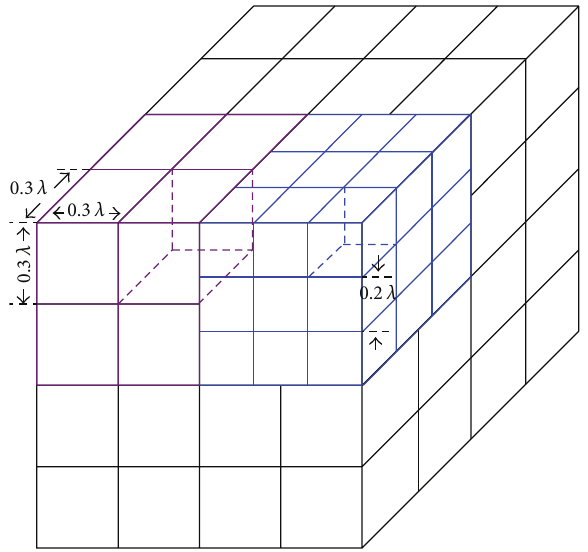
Figure 1: Two kinds of the bottom-layer boxes. For example, each purple or black box is a bottom-layer box in the octree structure, while each blue box is a bottom-layer box in the 27-tree